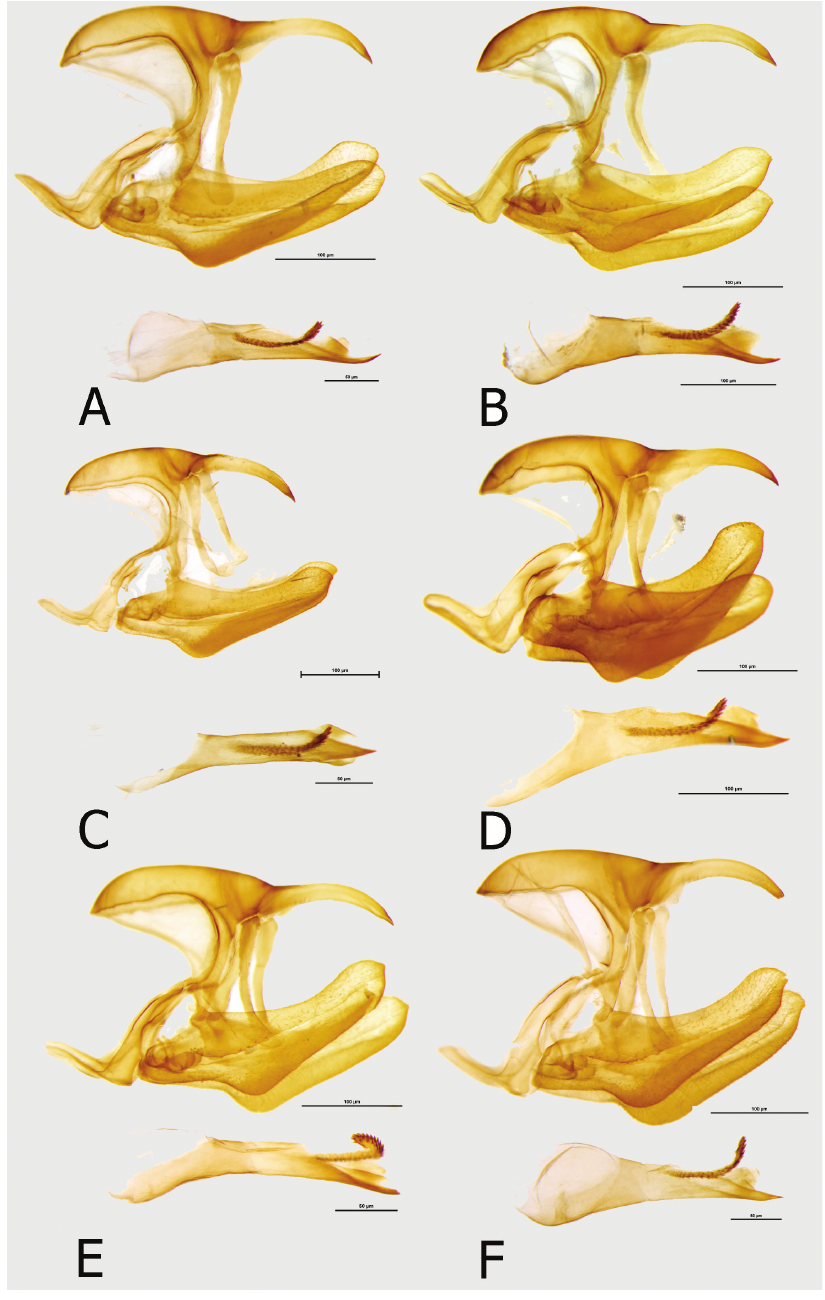
Figure 9. Male genitalia (in lateral view, aedeagus extracted): A E. cyparissa cyparissa Guma, Sierra Leone B E. cyparissa tai Tai, Ivory Coast C E. cyparissa nimbina Mont Nimba, Guinea D E. cyparissa aurantina Abengourou, Ivory Coast e E. cyparissa aurata Ebogo, Cameroon F E. cyparissa nominalina Bangui, Central African